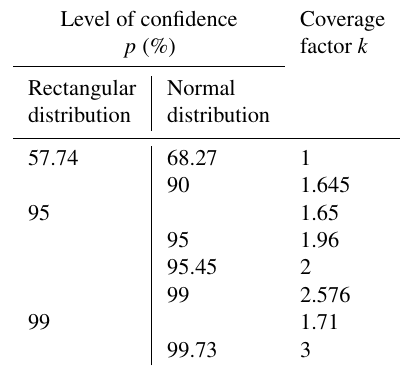
Table 1. Correspondence between key values of coverage factor and level of confidence for two common probability